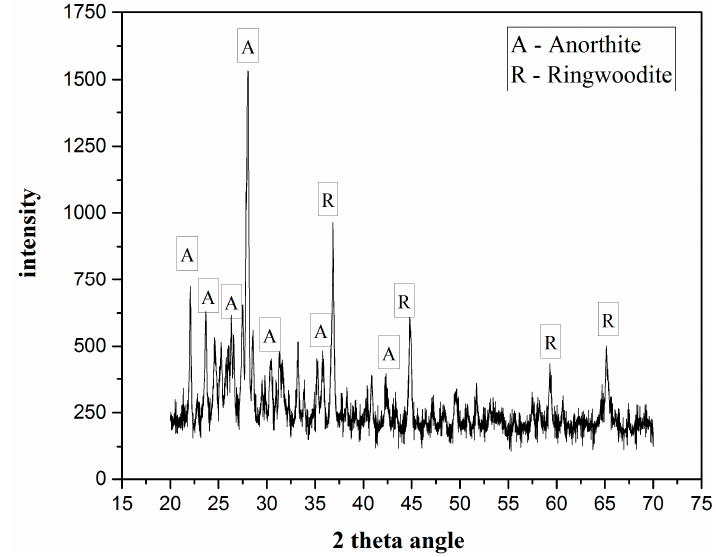
Figure 8. XRD pattern of fly ash-based support.